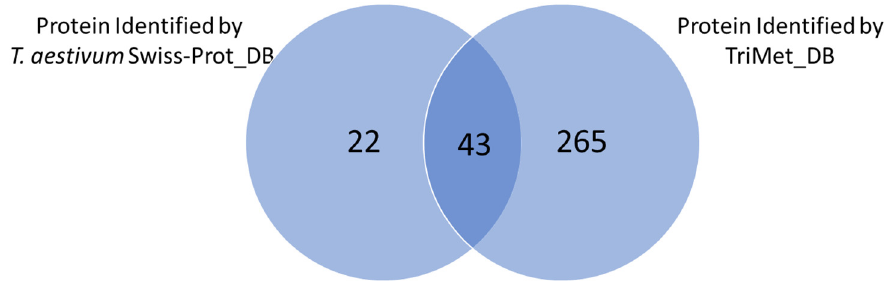
Figure 3. Venn diagram reporting the proteins identified using two different databases, T. aestivum Swiss-Prot_DB and TriMet_DB.